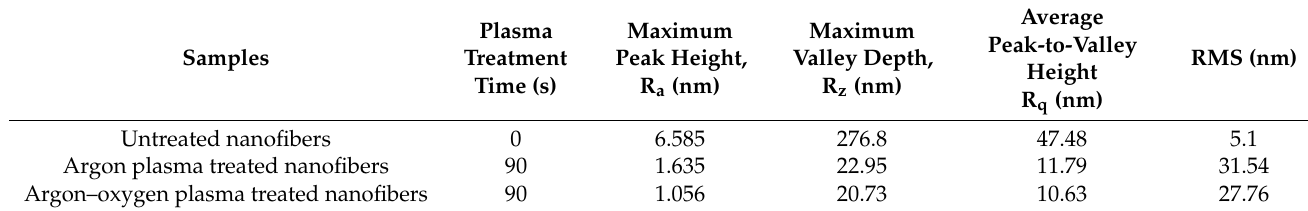
Table 1. Roughness values as a function of plasma treatment on crosslinked gelatin nanofibers.